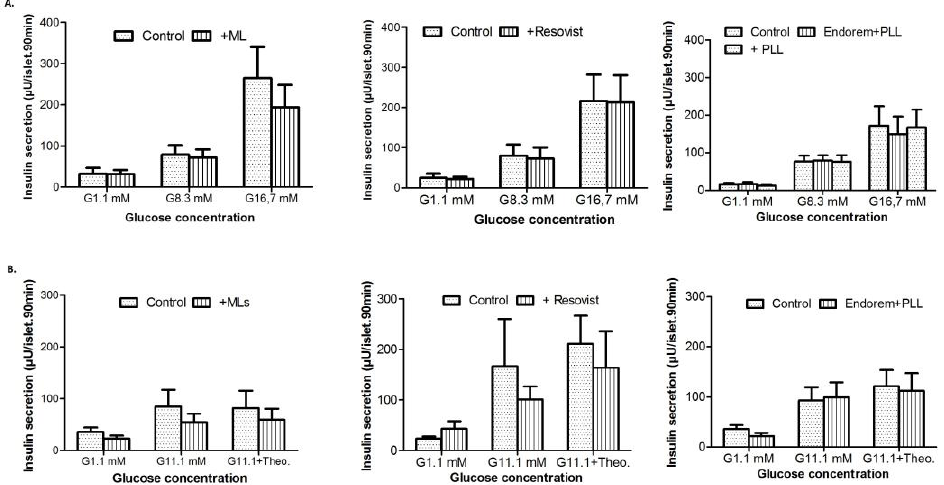
Figure 5. Effect of labeling PIs on their insulin secretion: ( A ) Insulin release from PIs in the presence of glucose (1.1, 8.3 and 16.7 mM) when labeled with MLs (left panel), Endorem + PLL (middle panel), and Resovist + PLL (right panel) at 50 μg/mL for 24 h. ( B ) Insulin release from islets labeled with magnetoliposomes, Endorem + PLL, and Resovist + PLL at 50 μg Fe/mL, in the presence of low (1.1 mM) and high (11.1 mM) glucose concentrations with and without 1.4 mM theophylline). These results indicate no negative effects on glucose-stimulated insulin secretion (GSIS).